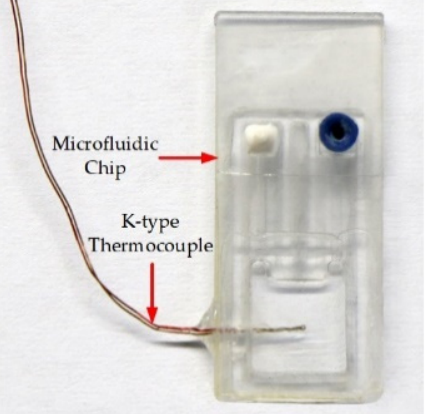
Figure 6. Solution temperature monitoring